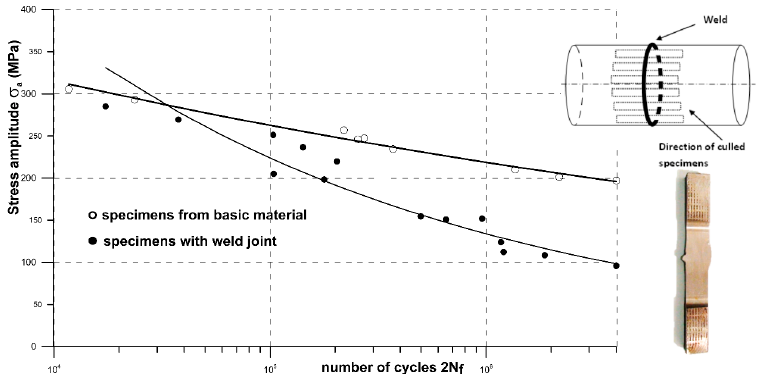
Figure 5. Dependency σ a -2N f [15] for the base material and pipeline specimens made from the real pipeline with the weld joint.